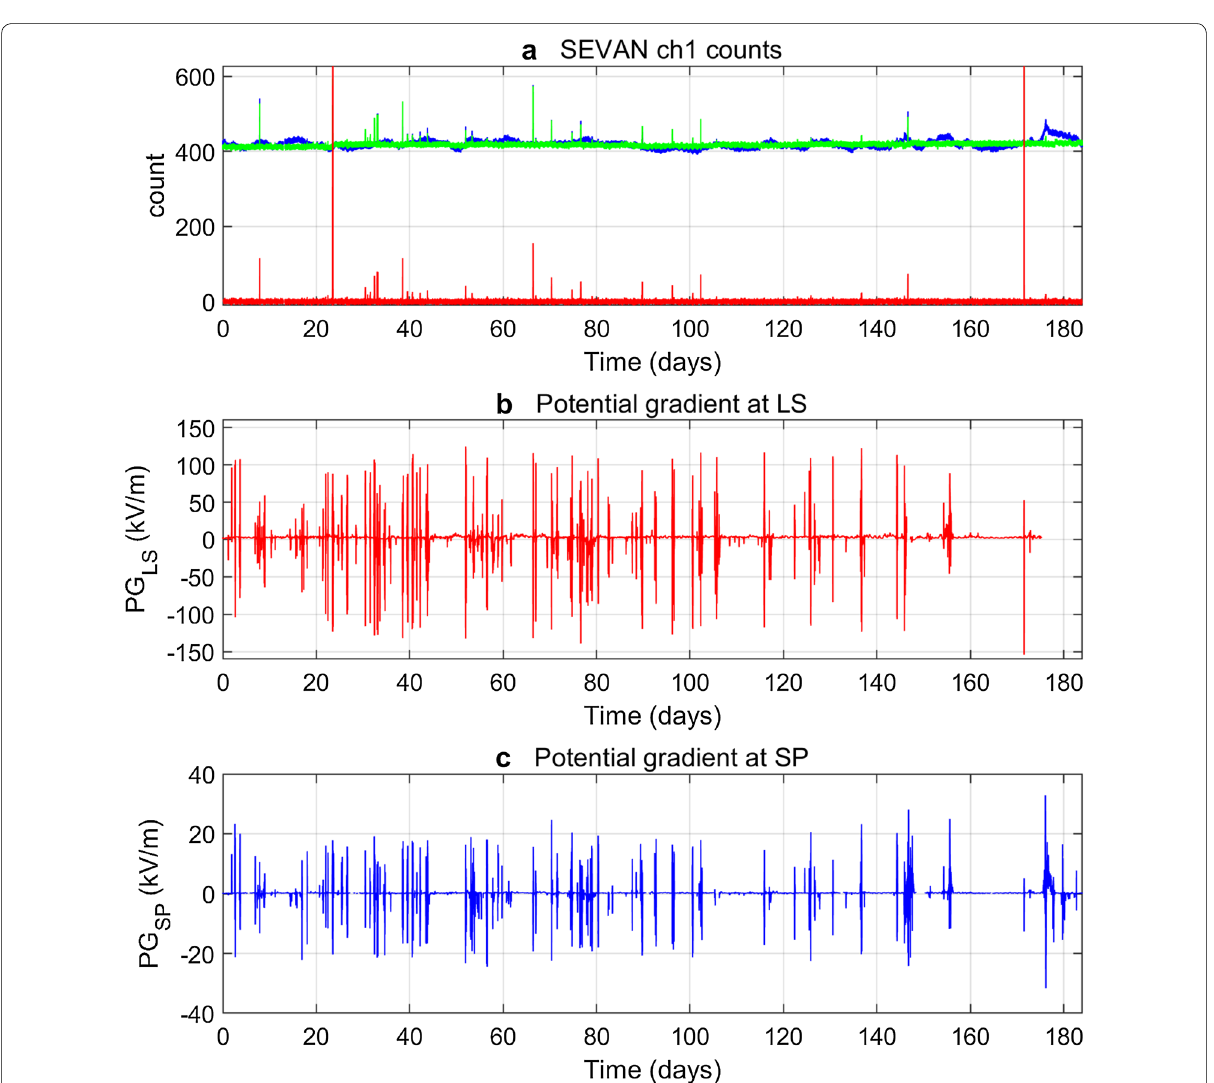
Fig. 2 Secondary cosmic rays and PG measured in 2018 from 1 May to 30 October. a 1-min averages of N raw counts in the SEVAN channel 1 (blue), counts N cor after correction on pressure (green), count enhancements N res with respect to background values (red). b PG measured at Lomnický peak. c PG measured at Skalnaté